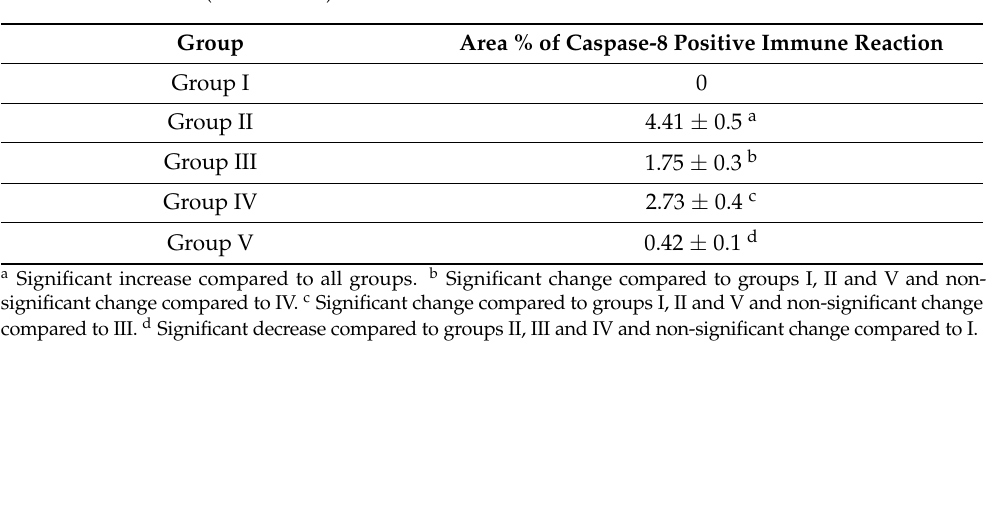
Table 3. Effect of alcohol and/or ATOR treatment on caspase-8 immune reaction and the influence of ASA administration (mean ±